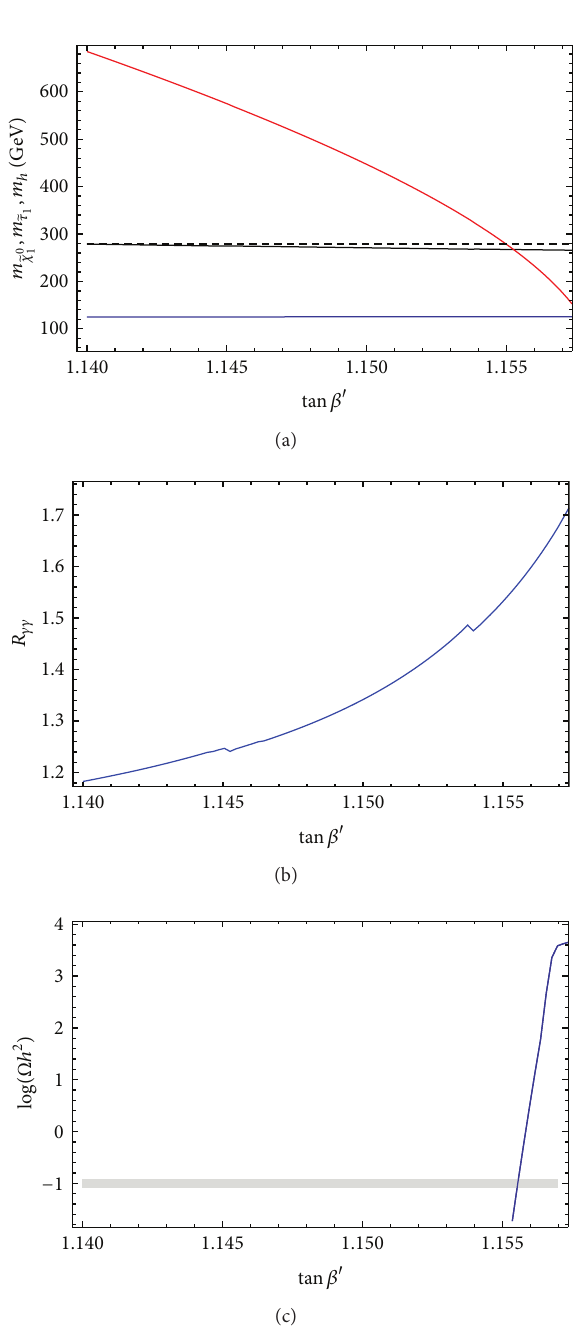
Figure 10: (a) The mass of the SM-like Higgs (bottom (blue line)), of the stau (middle (black) line, where the dashed line represents a reference unchanged value), and of the lightest neutralino (top (red) line); (b) the diphoton branching ratio; (c) the neutralino relic density as a function of tan 𝛽 󸀠 . The other parameters have been chosen as 𝑚 0 = 673 GeV, 𝑀 1 / 2 = 2220 GeV, tan 𝛽 = 42 . 2, 𝐴 0 = − 1842 . 6, 𝑀 𝑍 󸀠 = 2550 GeV, and = 1 ⋅ 0 . 𝑌 𝑥